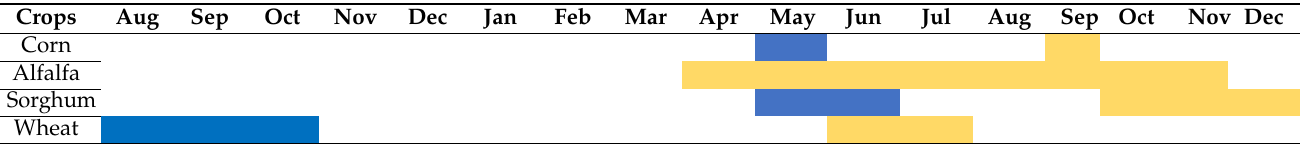
Blue shade: planting dates; yellow shade: harvesting.